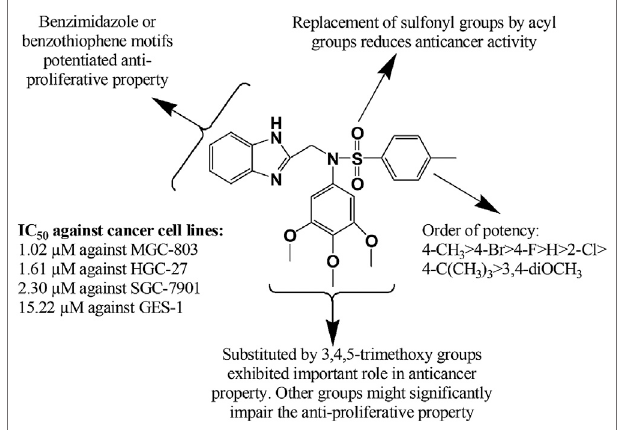
FIGURE 11 | Structure activity relationship (SAR) of benzimidazole derivatives having anticancer potentiality. The fi gure represents the SAR studies accomplished by Song, J. et al.